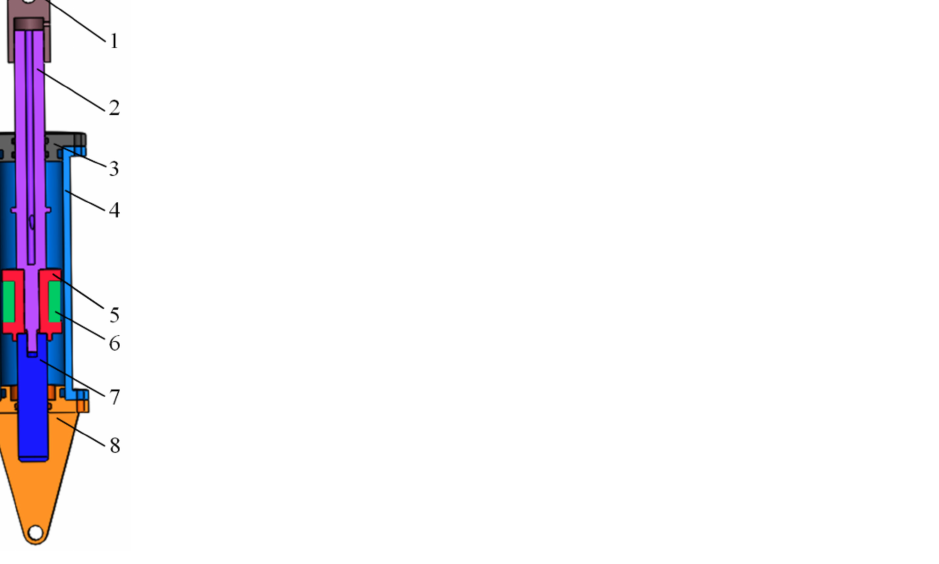
Figure 6. Schematic diagram of MR damper. (1) Upper lifting lug, (2) piston rod A, (3) end cover, (4) cylinder body, (5) coil winding frame (6) excitation coil, (7) piston rod B, (8) lower lifting